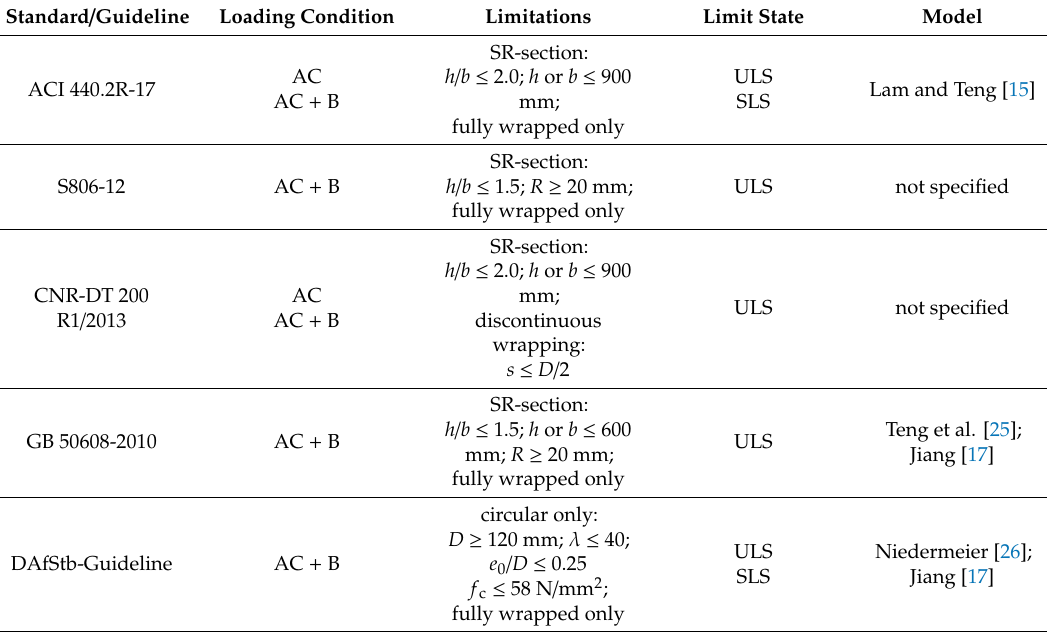
Table 2. General information for the various standards, including limitations and the models